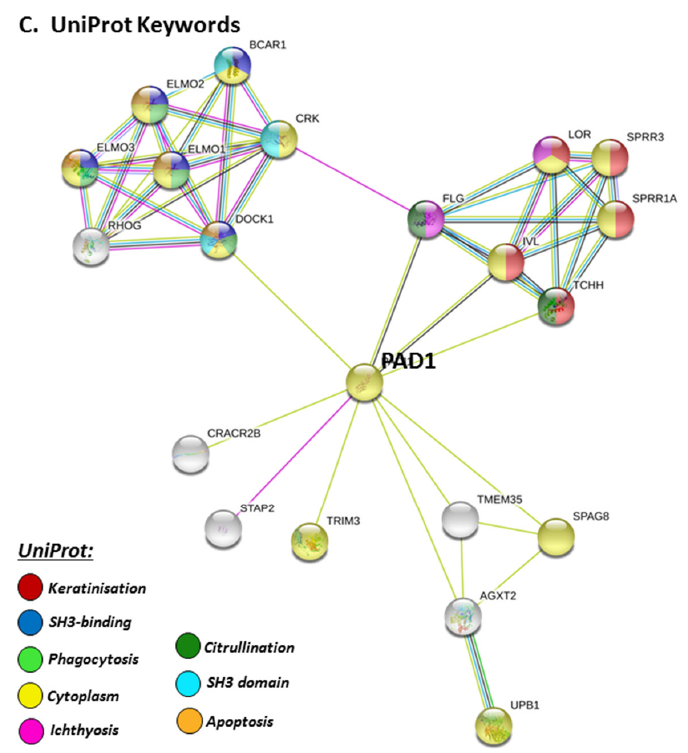
Figure 5. GO and KEGG analysis for PAD1, highlighting GO biological pathways ( A ) KEGG pathways ( B ) and UniProt keywords ( C ). Colour code for the di ff erent pathways is shown within the figure. Individual coloured lines represent specific protein interactions that have been identified through interactions that are known (referring to experimentally determined connections and curated databases), through interactions that are predicted (referring to gene fusion, gene neighbourhood, gene co-occurrence) or through interactions identified via text mining, co-expression or protein homology (please refer to the colour key provided in the figure for the different connective lines) (PPI enrichment p -value: 8.01 × 10 − 8 ). Furthermore, PAD2 protein interaction networks indicate a strong role in immune responses, including innate immunity, mucosal immunity, response to stress, anti-microbial, antifungal